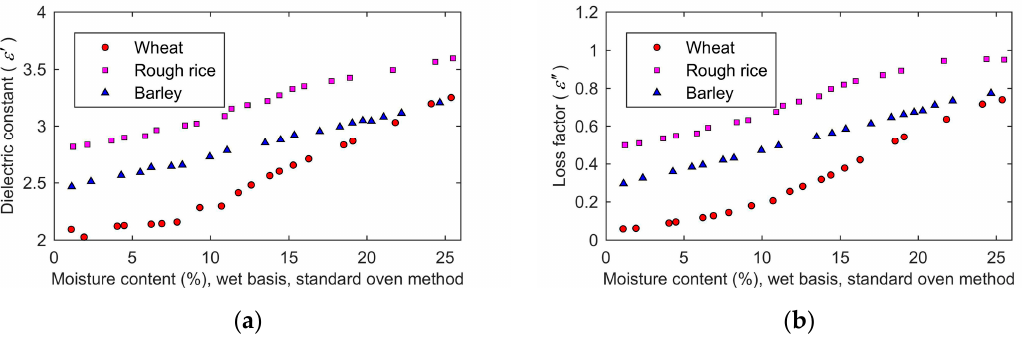
Figure 14. The moisture content dependence of the complex permittivity: ( a ), dielectric constant; ( b ), loss factor.